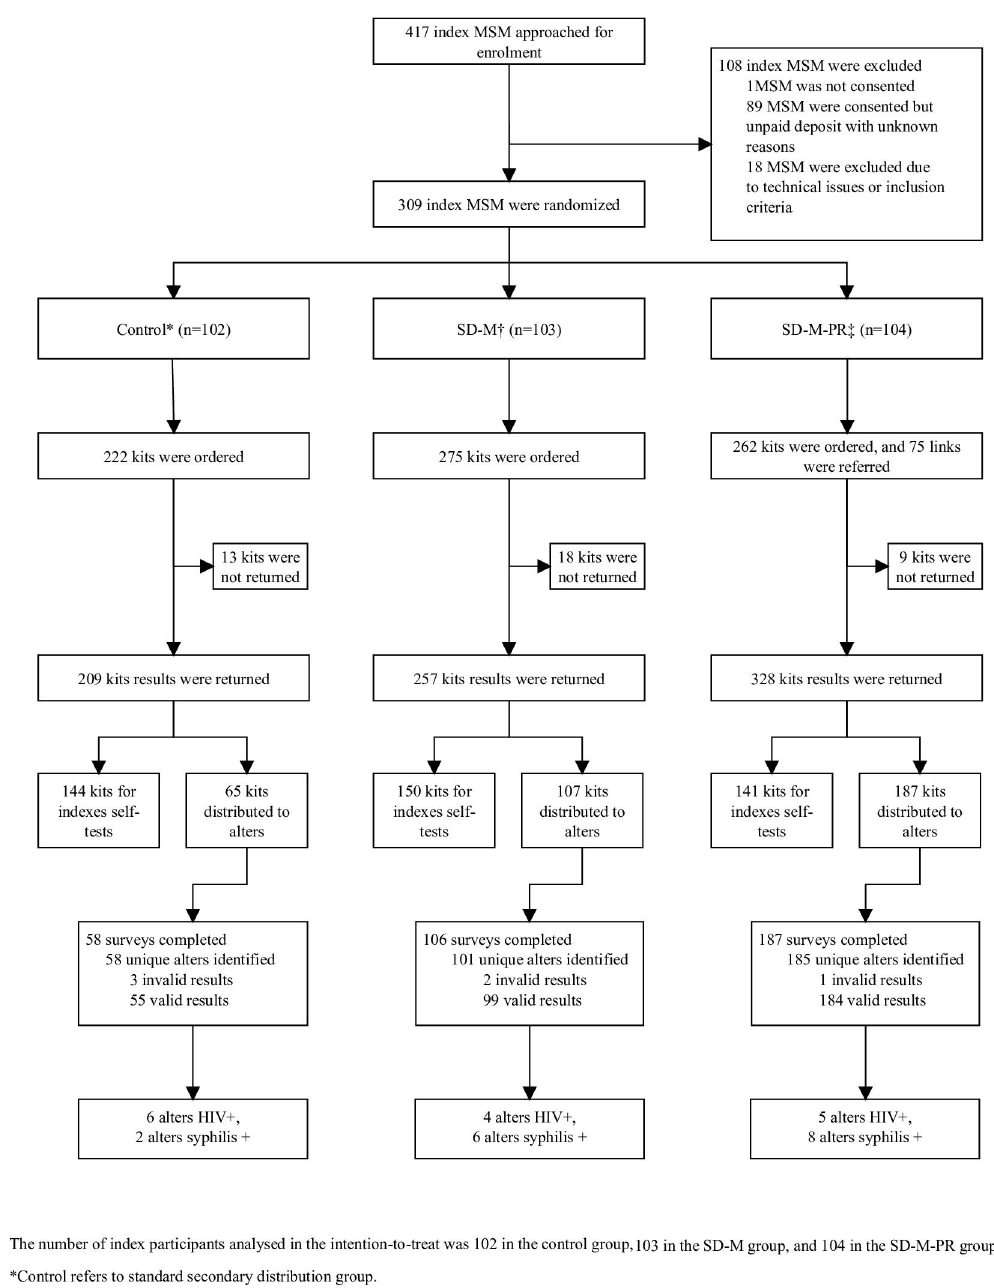
Fig 1. Trial profile. M AU : AbbreviationlistshavebeencompiledforthoseusedthroughoutFigs 1 and 2 : Pleaseverifythatallentriesarecorrect : SM, men who have sex with men; SD-M, secondary distribution with monetary incentives; SD-M-PR, secondary distribution with monetary incentives plus peer referral.